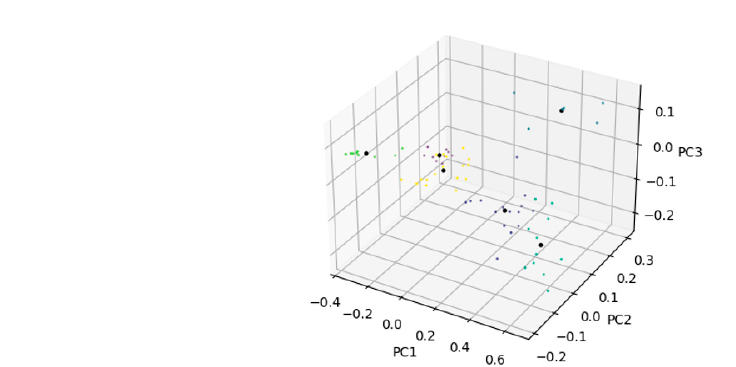
Figure 8. Three-dimensional K-Means clustering visualization.